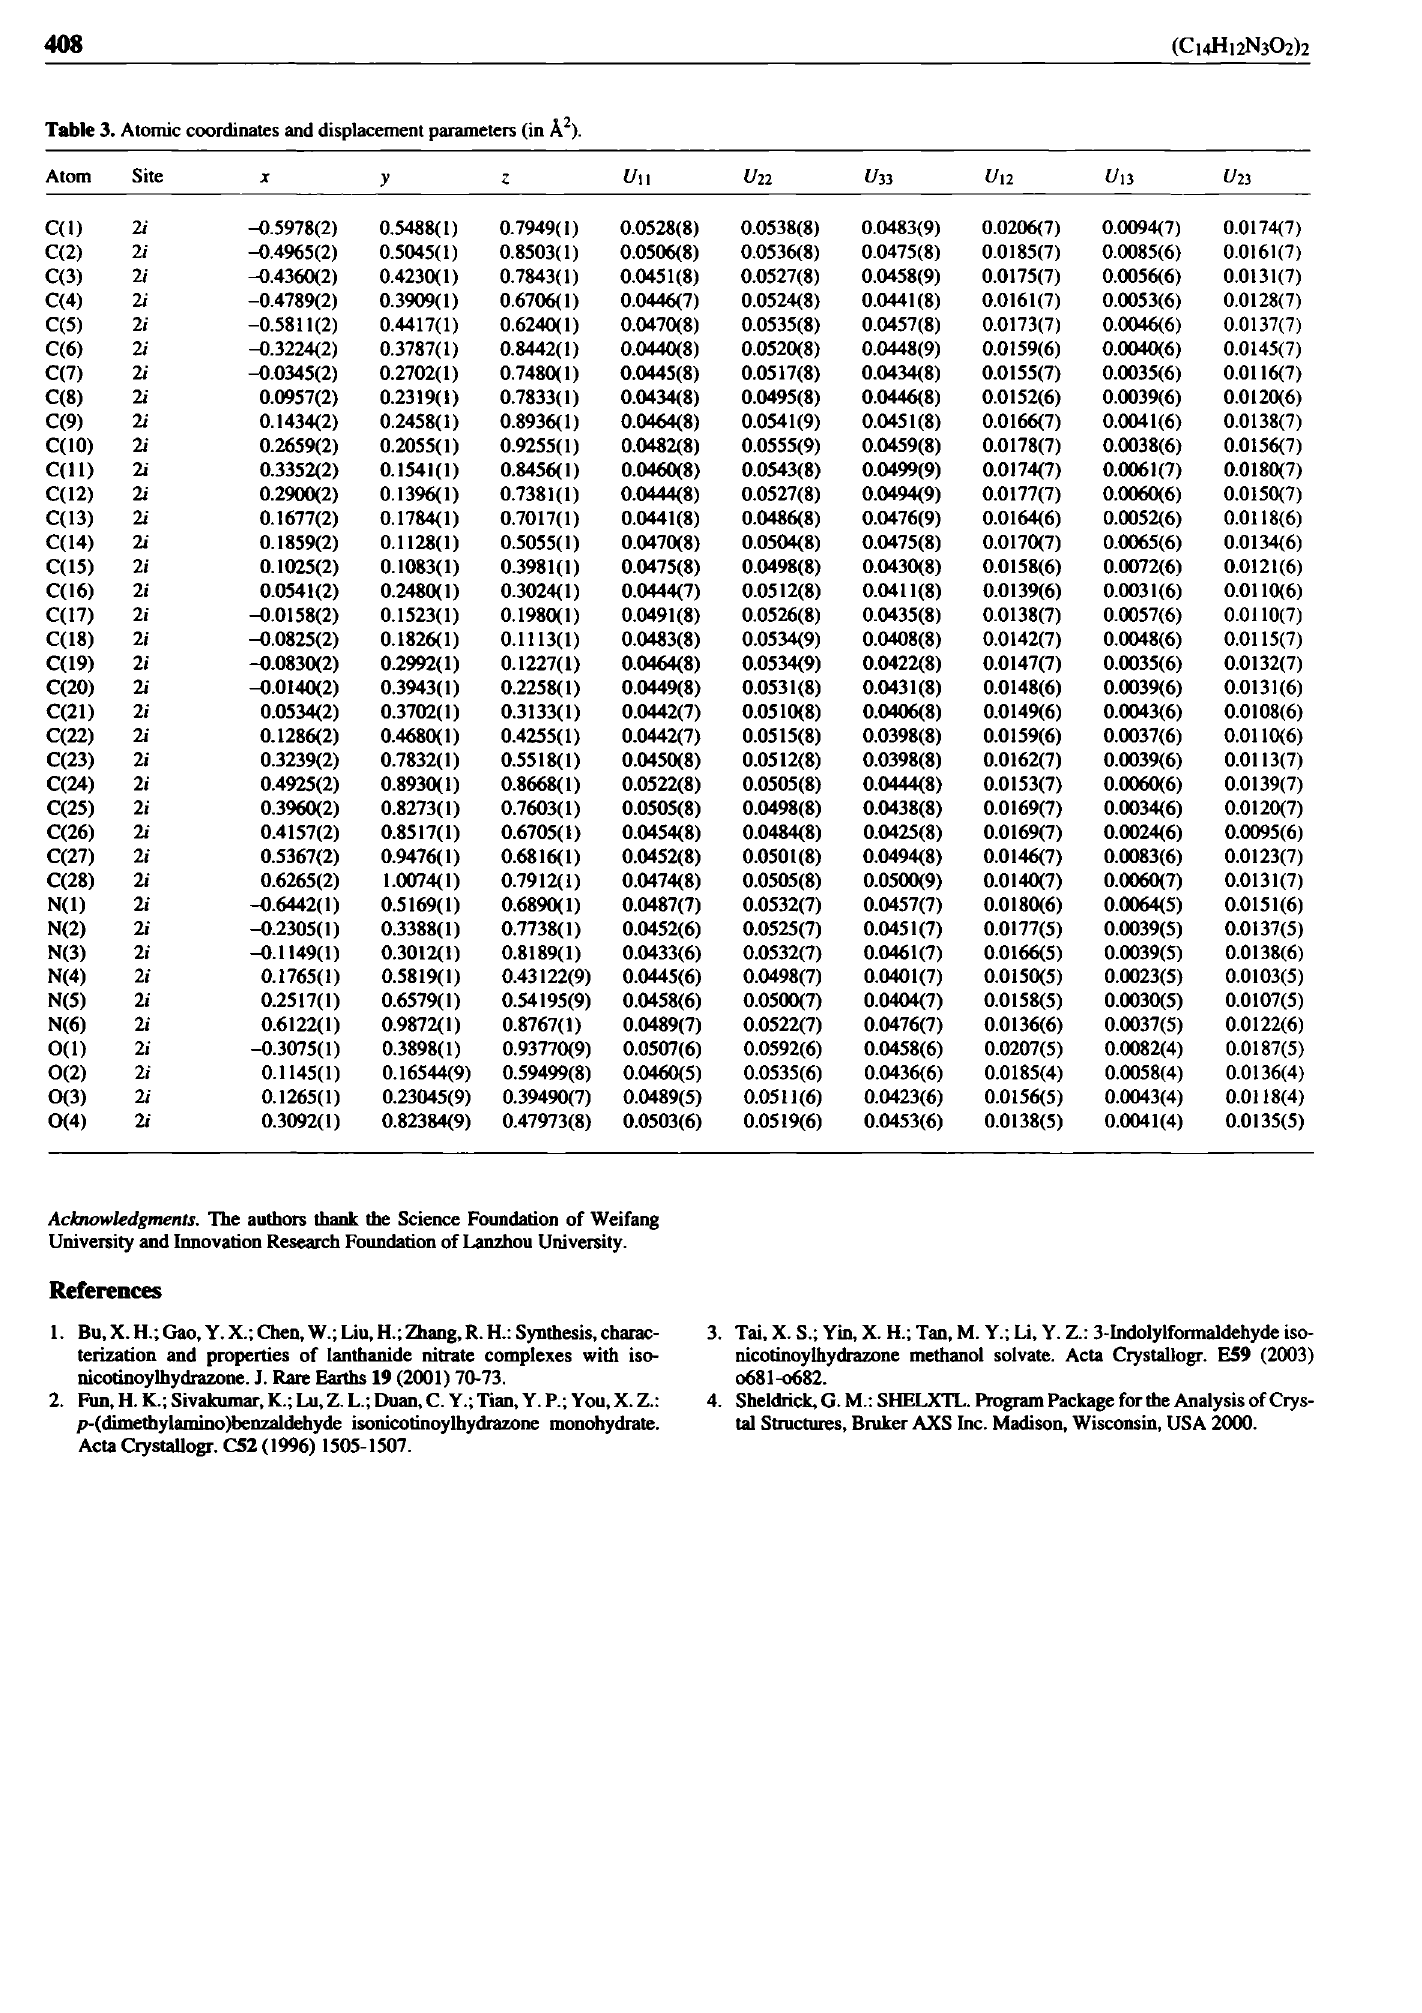
Table 3. Atomic coordinates and displacement parameters (in A 2